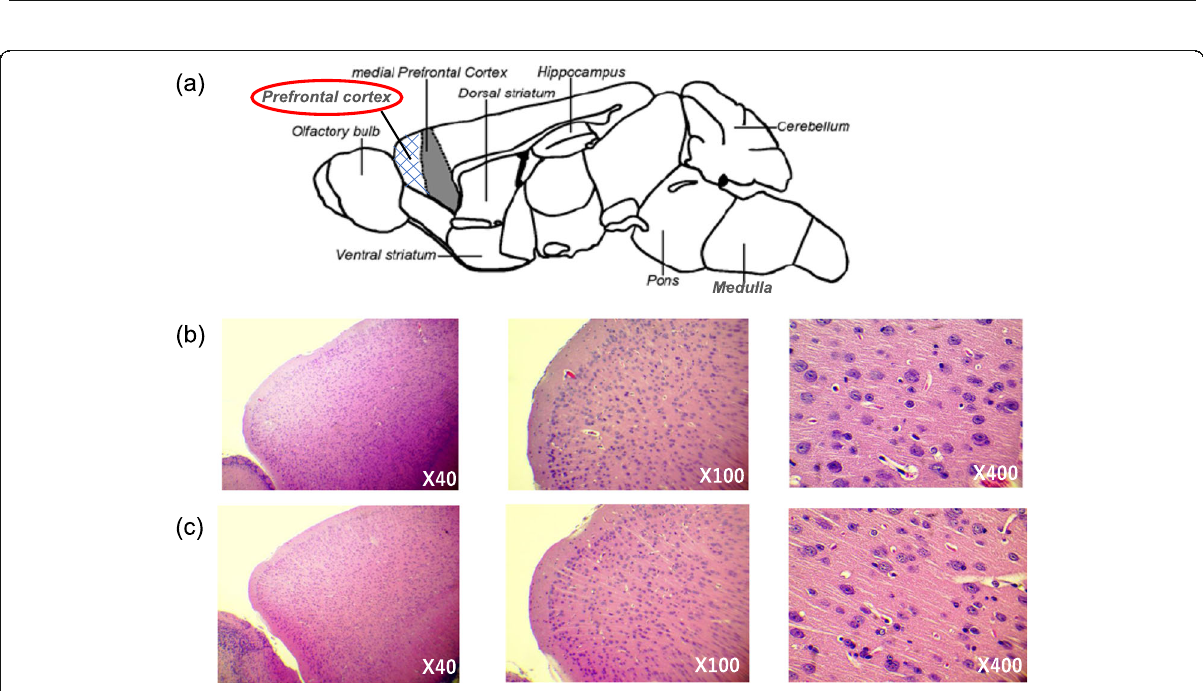
Fig. 3 Social behavior test at 74-week-old. a Sociability test and b social novelty preference test in the control group and the arsenic group of 74-week-old F2 male mice. Each bar represents the mean ± SE ( n = 9 – 15). E, empty; S1, stranger 1; S2, stranger 2